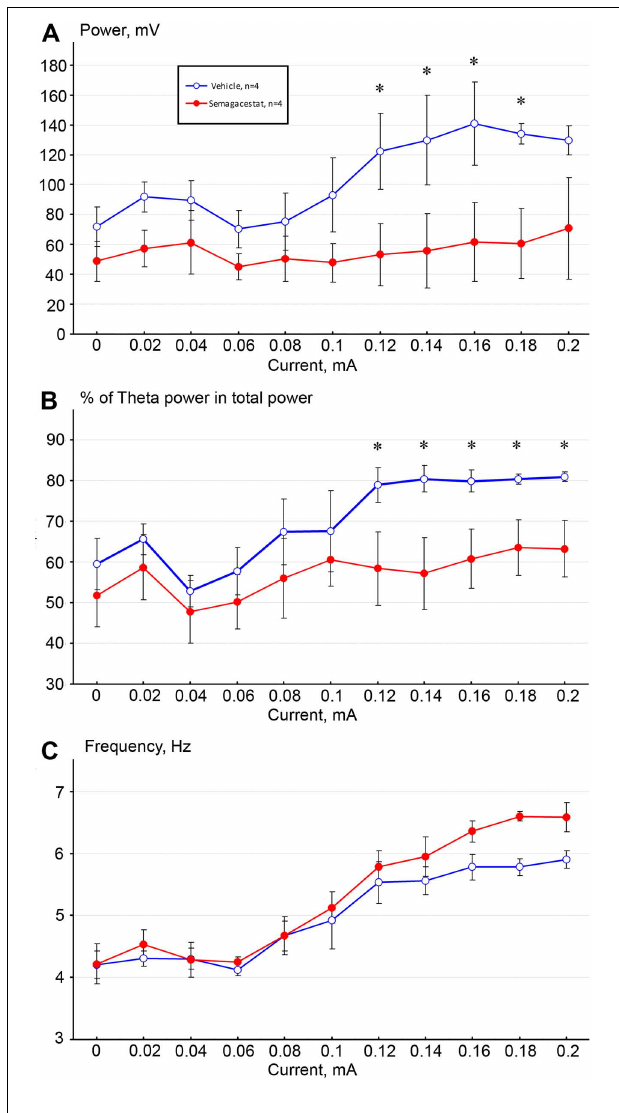
FIGURE 2 | Sub-chronic administration of semagacestat (twice daily 100 mg/kg, p. o. over 12 days, n = 4, RED symbols) significantly attenuated absolute (A) and relative (B) power of hippocampal theta oscillation elicited by stimulation of the nucleus pontis oralis with increasing currents (0–0.2 mA) compared to vehicle-treated control C57BL/6 mice ( n = 4; BLUE symbols; * p < 0.05). In contrast, no significant difference in peak frequency in elicited theta activity was noticed (C)